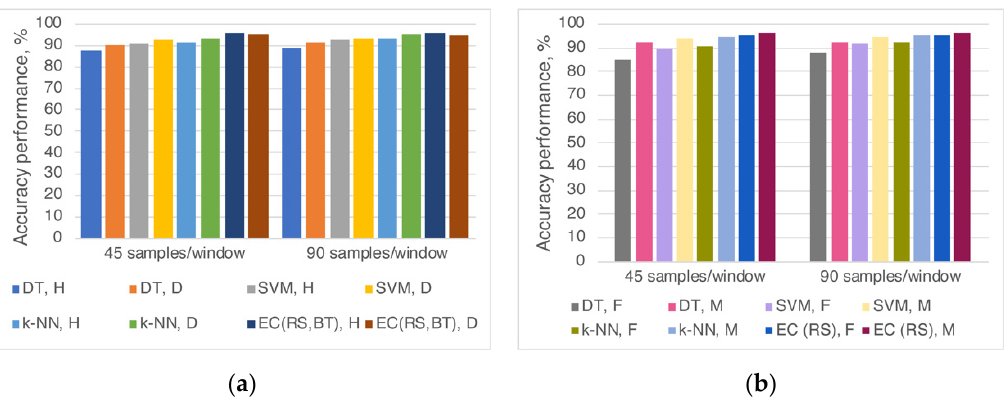
Figure 2. Accuracy performances of the algorithms for rest and effort events classification when participants were divided according to ( a ) health condition (H—healthy; D—diabetes) or ( b ) gender (F—female; M—male).